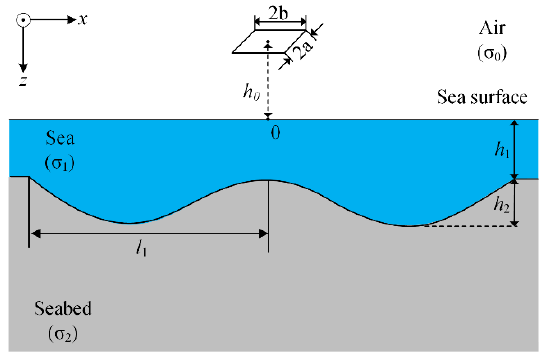
Figure 7. 2.5D two-layered model with a rugged seabed.